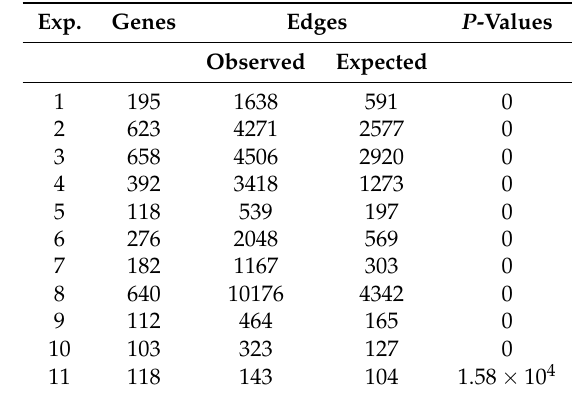
Table 10. PPI enrichment by the STRING server. Column “genes” shows numbers of genes recognized by the STRING